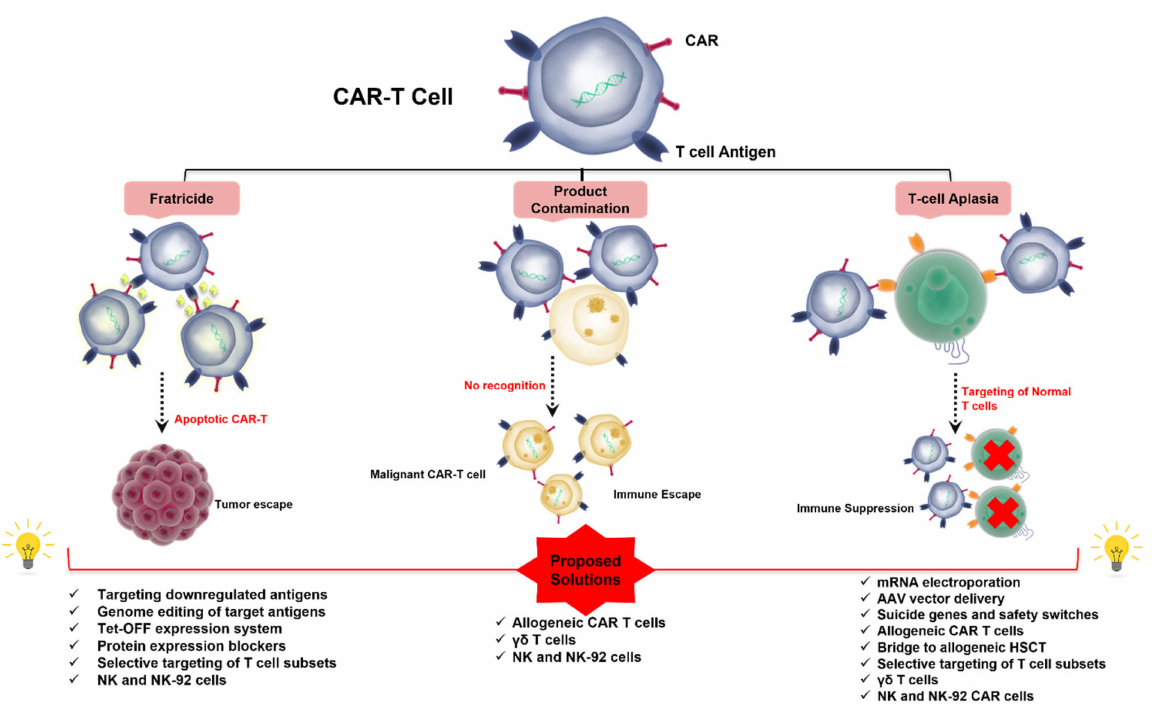
Figure 1. Challenges to the application of CAR-based therapy in T-cell malignancies and proposed solutions. CAR-T cell therapy can be complicated by fratricide, contamination of the final product by transduced tumor cells, as well as T-cell aplasia. CAR: chimeric antigen receptor; AAV: adeno- associated virus; HSCT: hematopoietic stem cell